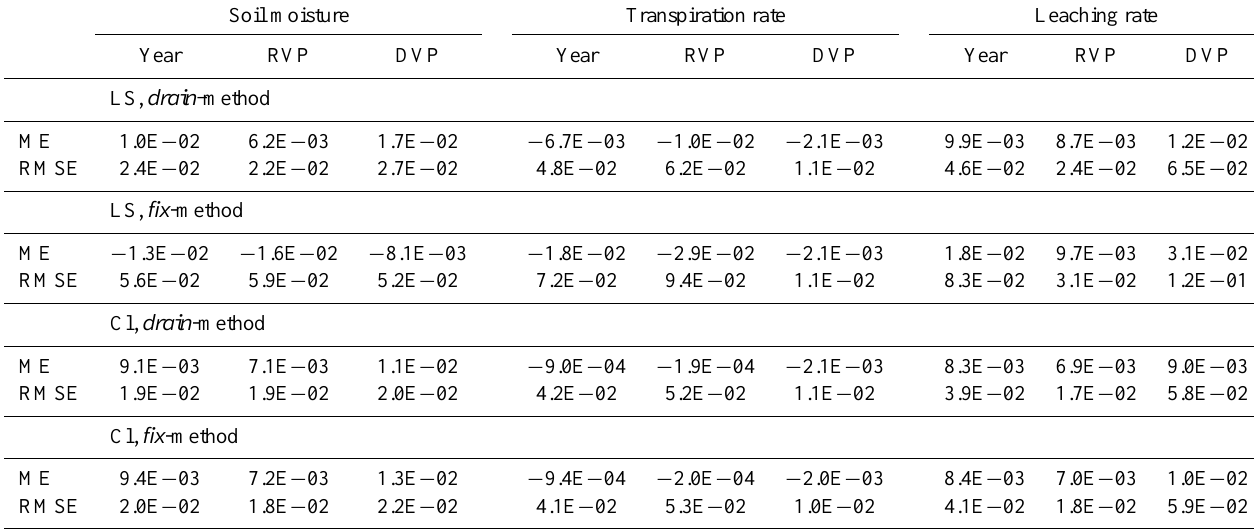
Soil moisture Transpiration rate Leaching rate